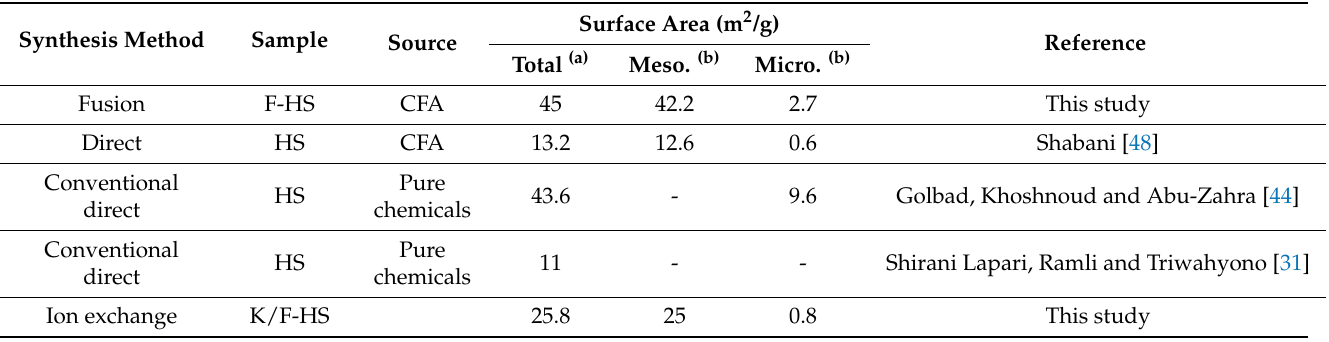
Table 2. Textual properties of parent and ion exchange-modified